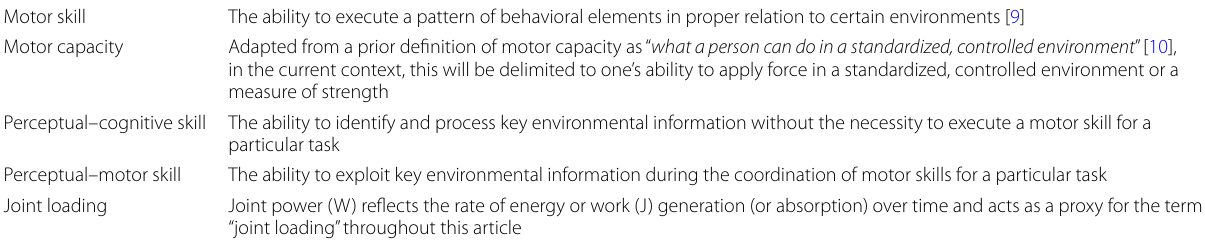
Therefore, the following terms include definitions aligned with their use in the current manuscript (Fig. 1)